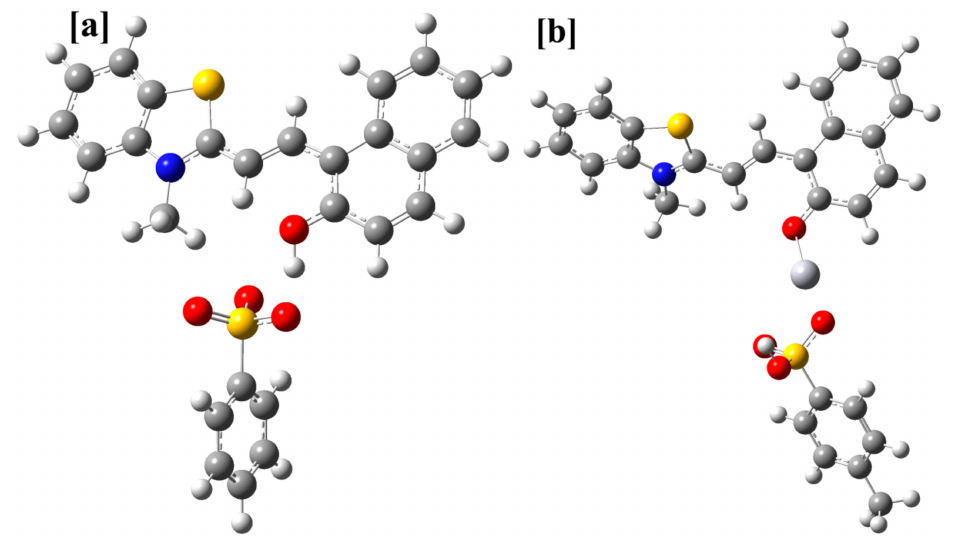
Figure 18. The DFT / PBE1PBE / 6-31G(d) / LANL2DZ optimized geometries of the most stable form of 1 and its complex with mercuric ion. (a) the geometry of the TTC form linked to a p -toluenesulfonate group, (b) the geometry of the TTC-Hg 2 +